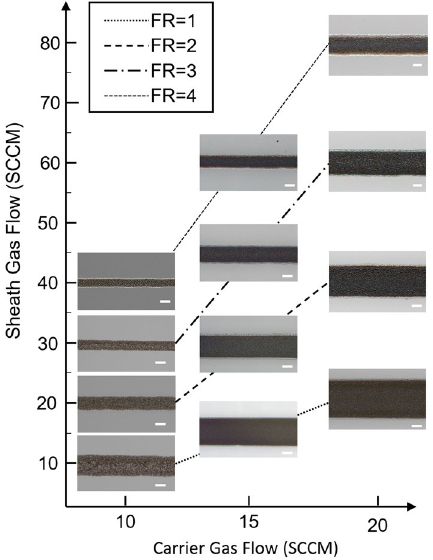
Figure 3. Optical microscopic micrographs of SPIONs lines printed on glass slides, illustrating the trend of the changes in line width by increasing the focus ratio (FR = sheath gas flow rate/carrier gas flow rate) for different carrier gas flow rates. Lines printed at the same focus ratio are grouped together. Scale bar 20